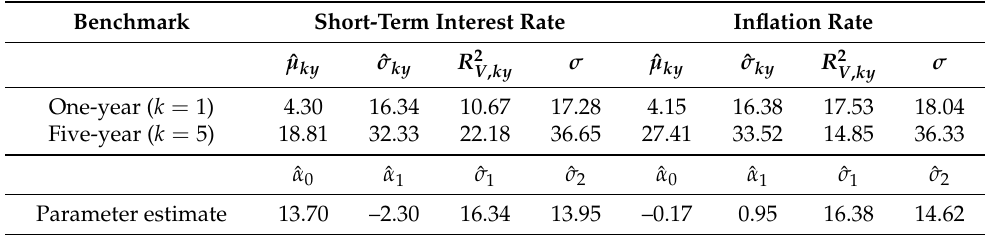
Parameter estimate 13.70